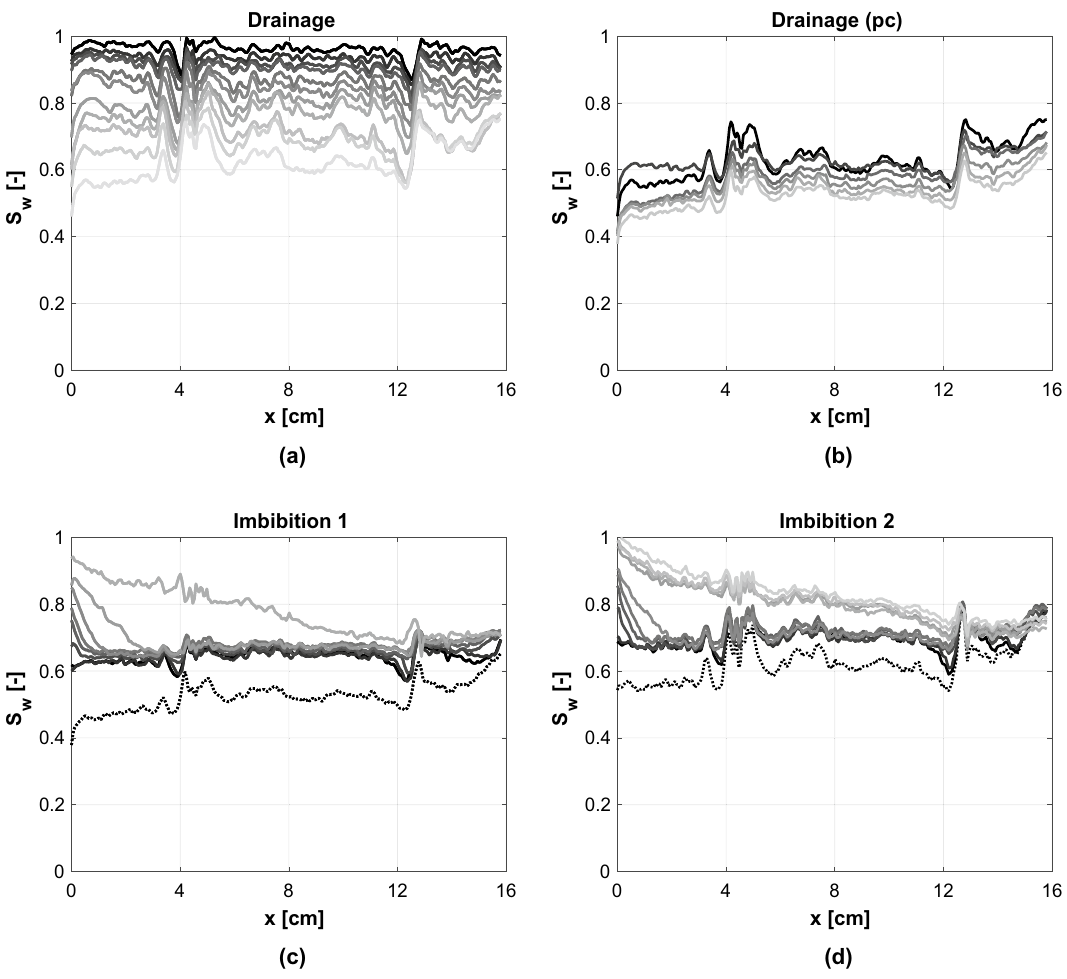
Figure 3. Steady-state saturation profiles along the length of the core. Each subplot indicates a different stage of the experiment. ( a ) Drainage relative permeability measurements. The water saturation is decreasing with increasing fractional flow of H 2 . ( b ) Drainage capillary pressure measurements. 100% H 2 is injected at different flow-rates. The water saturation is decreasing with increasing flow-rate. ( c , d ) Imbibition relative permeability measurements for Imbibition 1 and Imbibition 2, respectively. The water saturation increases with decreasing fractional flow of H 2 . The dotted line in the saturation profiles of Imbibition 1 and 2 shows the starting point of imbibition. Table 1 shows the experimental conditions during each stage of the